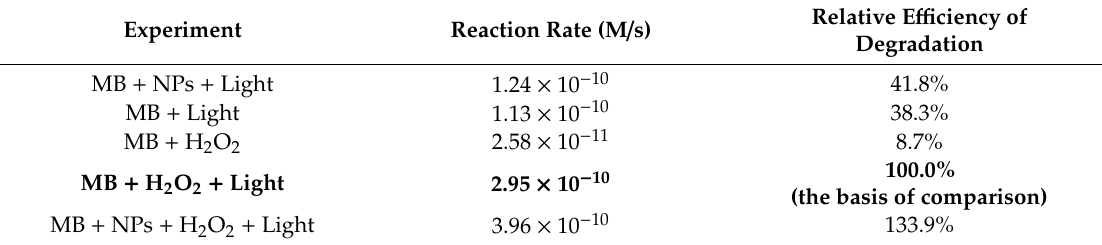
Table 2. Control experiments for MB degradation. Concentrations: MB = 1.5 × 10 − 5 mol/L, NP-3 = 22.73 mg/L, H 2 O 2 = 1.01 × 10 − 2 mol/L.